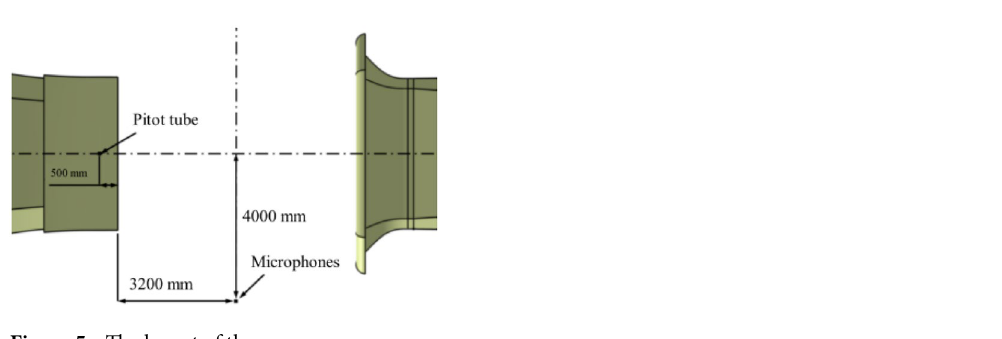
Figure 5. The layout of the